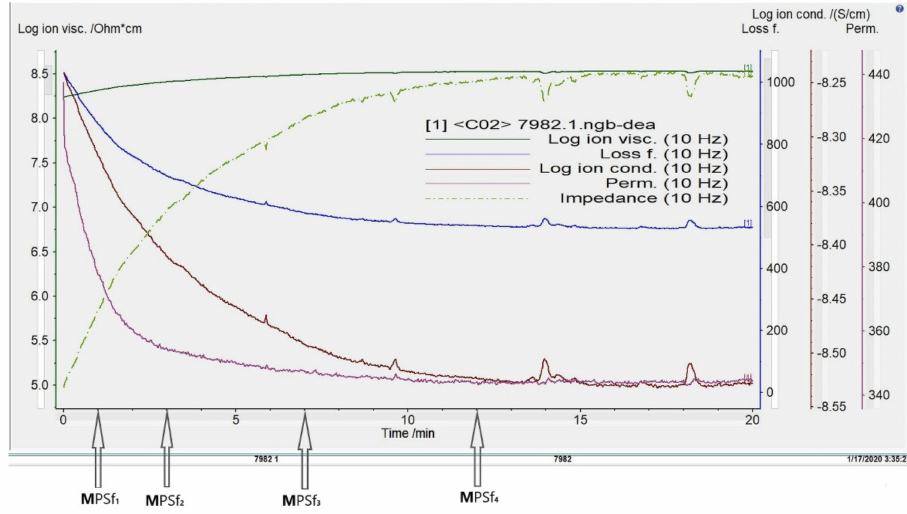
Figure 7. Diagram of electrochemical parameters vs. time and the moments when each film was introduced into the coagulation bath to obtain the analyzed membranes (MPSf1, MPSf2, MPSf3, and